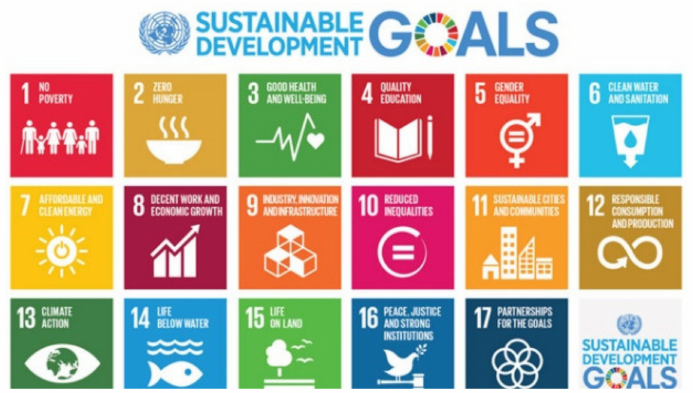
Figure 4. Sustainable Development Goals—2030 Agenda